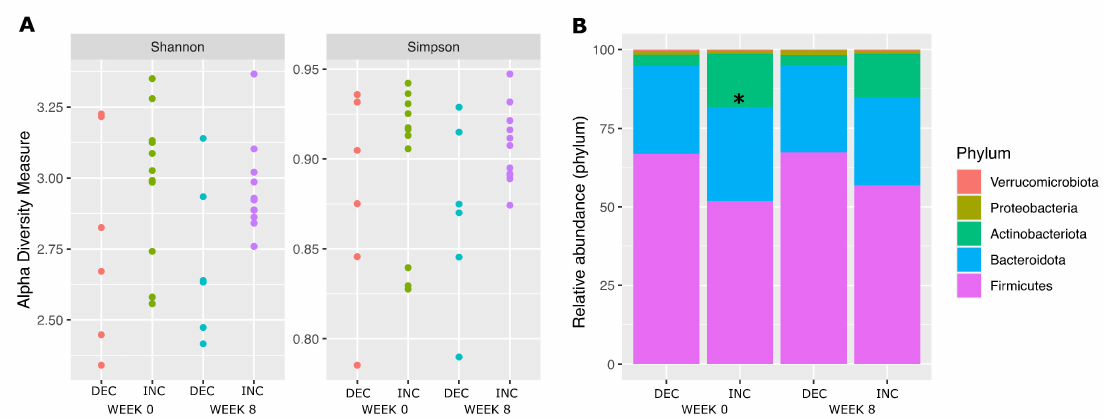
Figure 2. Composition of fecal microbiota according to TMAO subgroups. ( A ). α -diversity between TMAO subgroups according to Shannon ( left ) and Simpson’s reciprocal ( right ) indexes. Each participant is represented by a point. ( B ). Relative abundance of phyla among TMAO subgroups before and after Rb consumption. DEC and INC stand for TMAO decrease and TMAO increase subgroups, respectively. Asterisk stands for significant differences in INC versus DEC group at week 0.